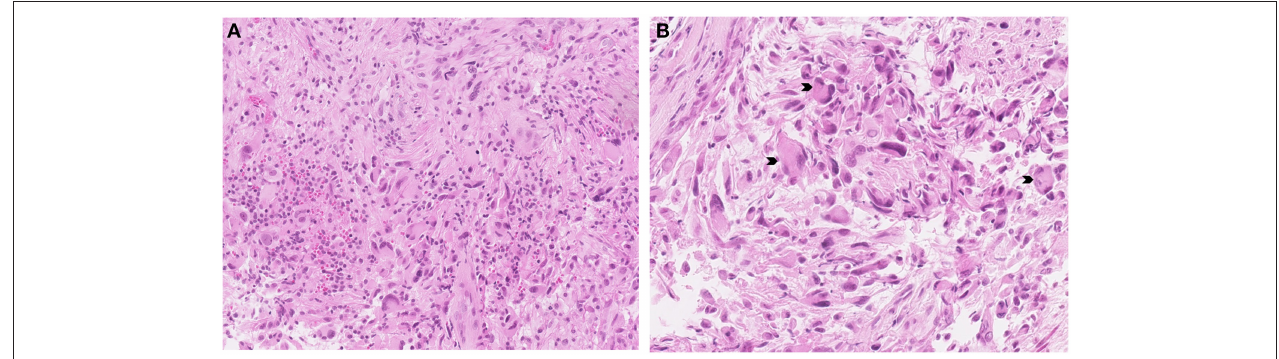
FIGURE 2 | Astrocytic glial cell population with grouped ganglion cells, marked in hematoxylin-Eosin-Saffron staining (original magnification X18) (A) , neuronal components characterized by larger numbers of binucleated or multinucleated cells (arrowheads) with a cellular glial background evaluated by